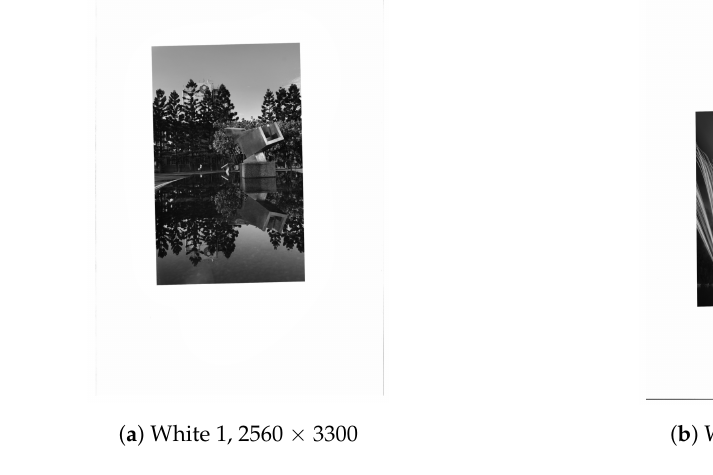
Figure 24. Test images, Part 1.